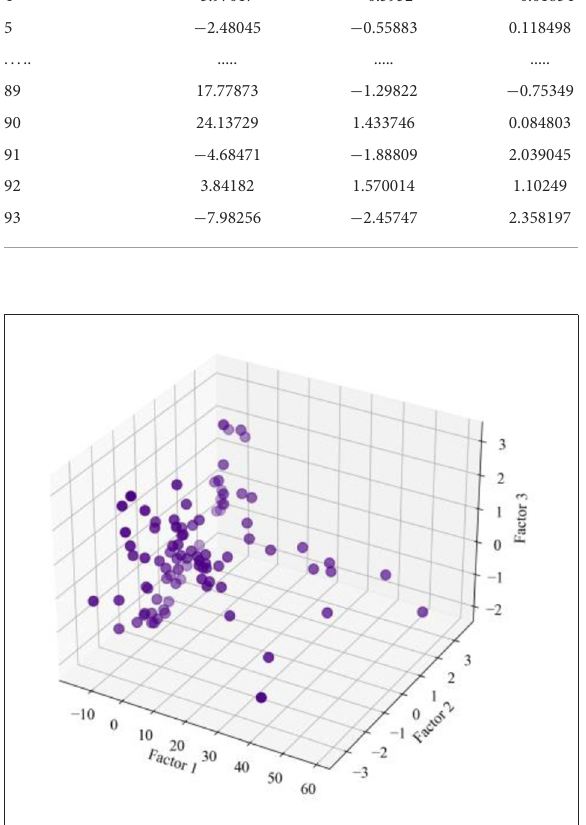
FIGURE7 3D visualization of ISOMAP based rockburst